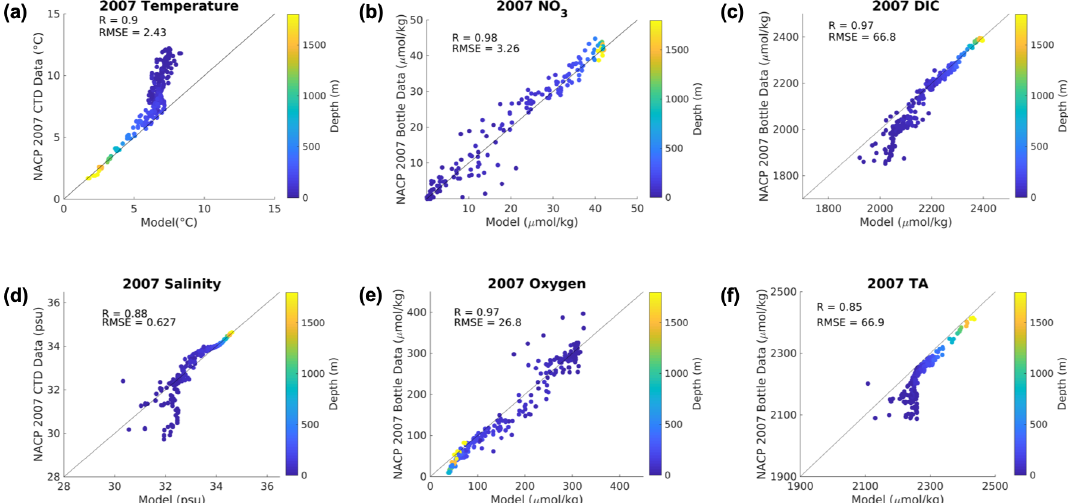
Figure 2. Model evaluation. Comparison between the bottle data from the 2007 cruise detailed in Feely et al. (2008) on the y axes and the simulated parameter ( x axis) from the 1.5km model forced with the 12km model at the boundaries. Colors indicate the depth where the bottle sample was taken. Correlation coefficient ( R ) and root mean squared error (RMSE) are reported as well. The units for each variable are labeled on the axes.